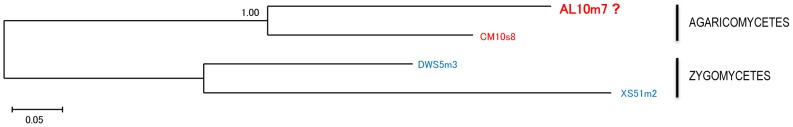
Consensus Bayesian tree tree based on ITS sequences for the 4 representative fungal OTUs of Agaricomycetes and Zygomycetes obtained in this study.Bayesian posterior probability values ≥0.95 are shown on the internodes.